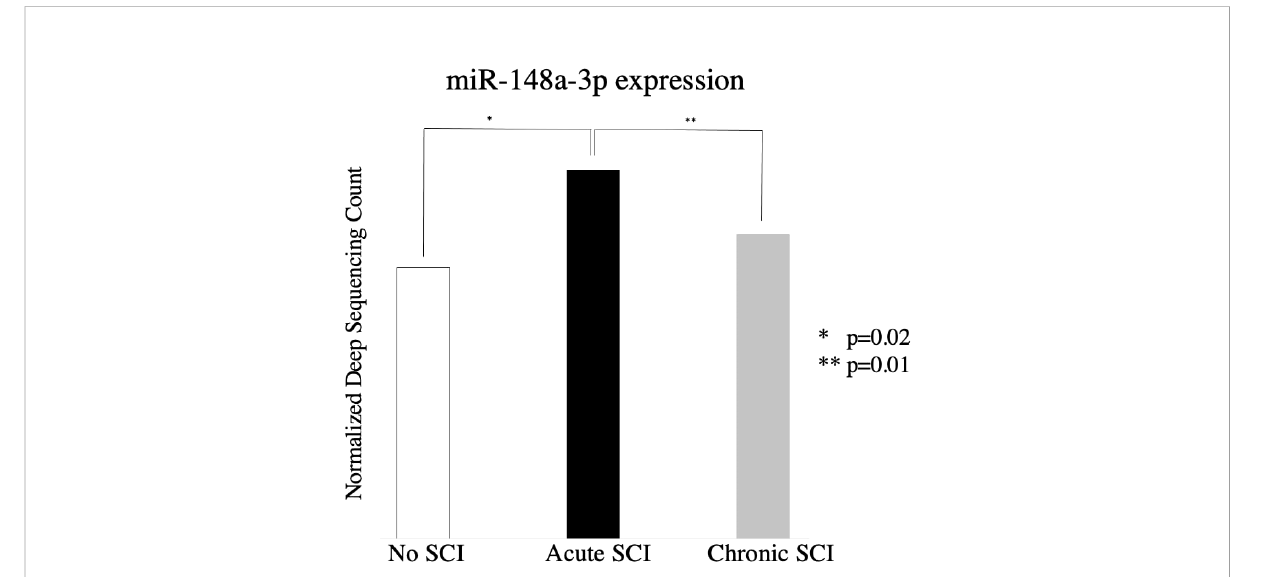
FIGURE 2 Relative expression of miR-148a-3p in subjects with no SCI, subjects with acute SCI, and subjects with chronic SCI.